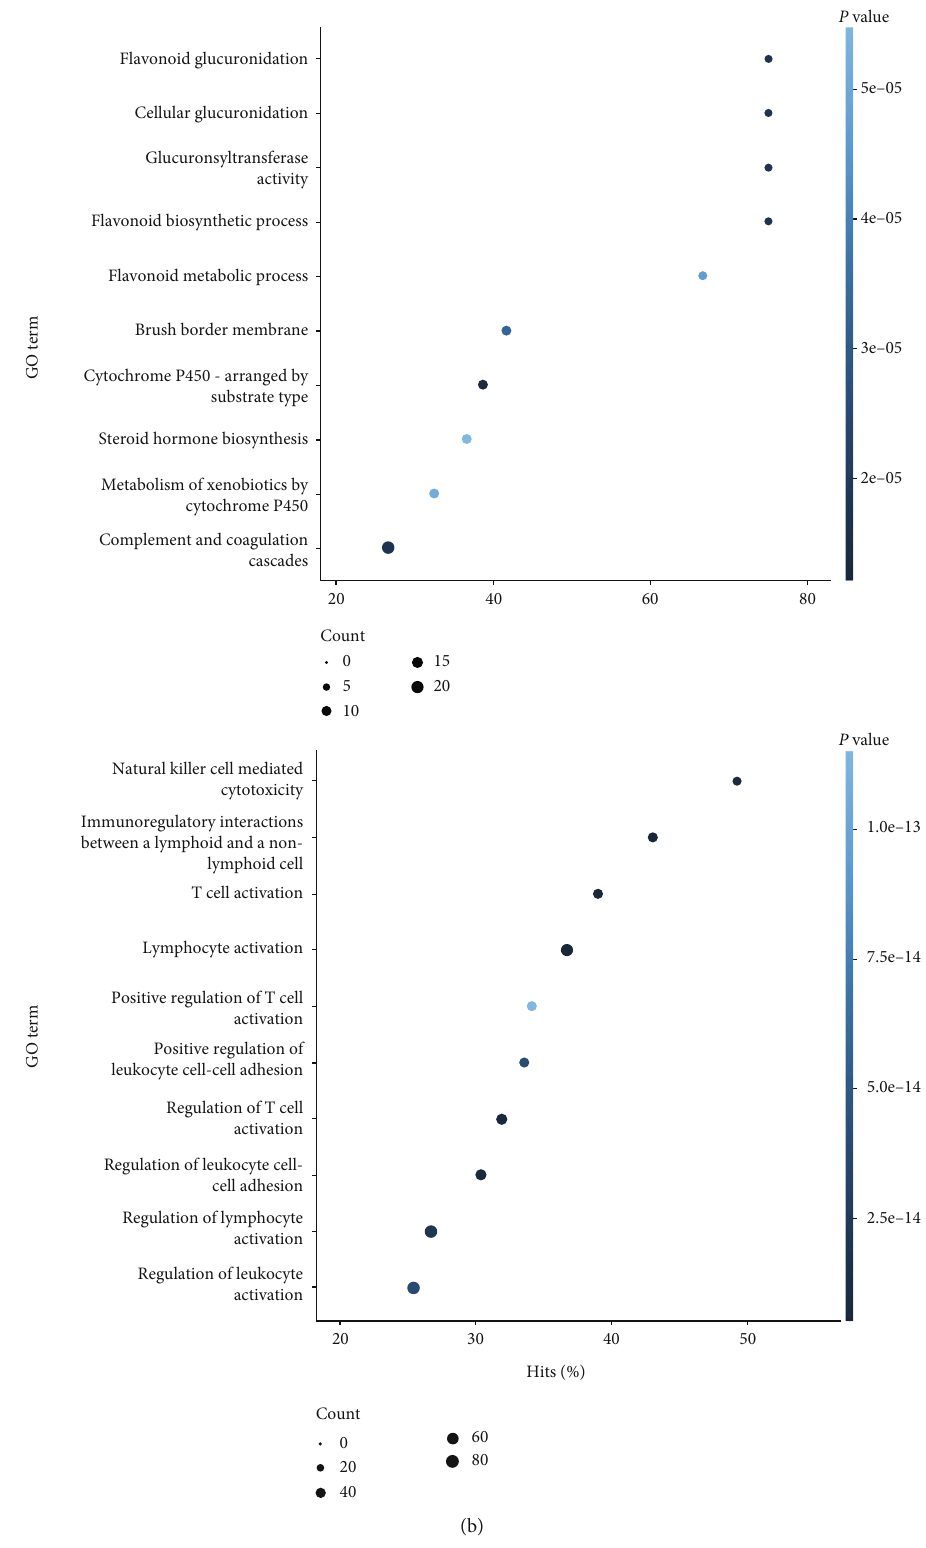
Figure 2: Di ff erential expressed genes between high stemness and low stemness iCCA cells. (a) Heatmap showing top 10 DEGs (upregulated and downregulated) between high stemness and low stemness malignant cells. (b) Di ff erences in pathway activity (scored per cell by l2p) between high and low stemness malignant cells (upper panel: upregulated genes; lower panel: downregulated